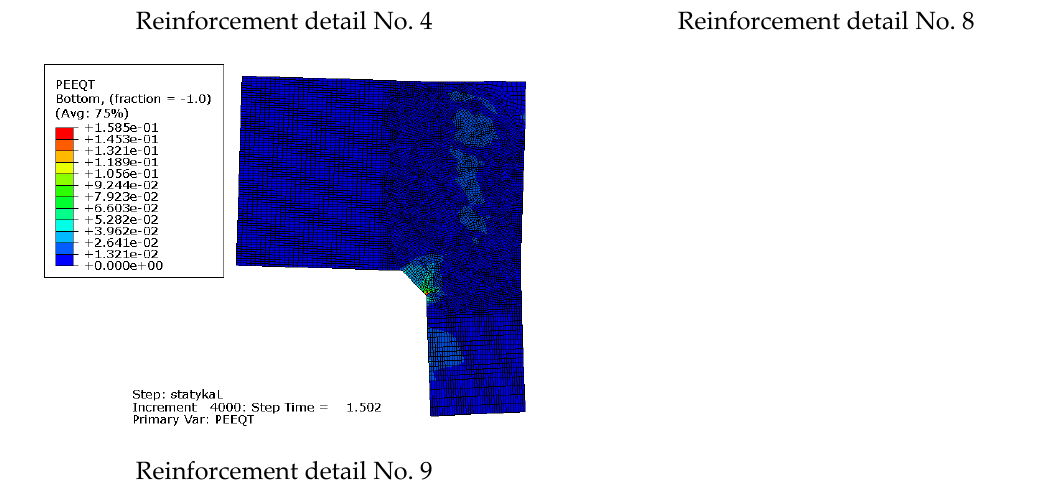
Figure 24. Equivalent plastic strains in tension PEEQT for the chosen reinforcement details in the plane stress state.